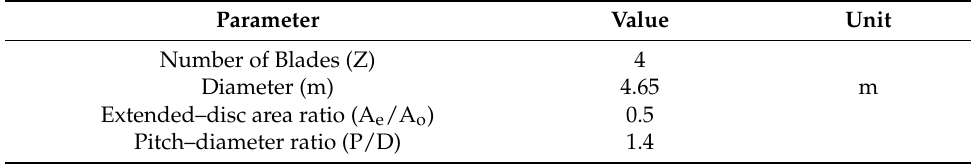
Table 3. Main parameters related to ship propeller.